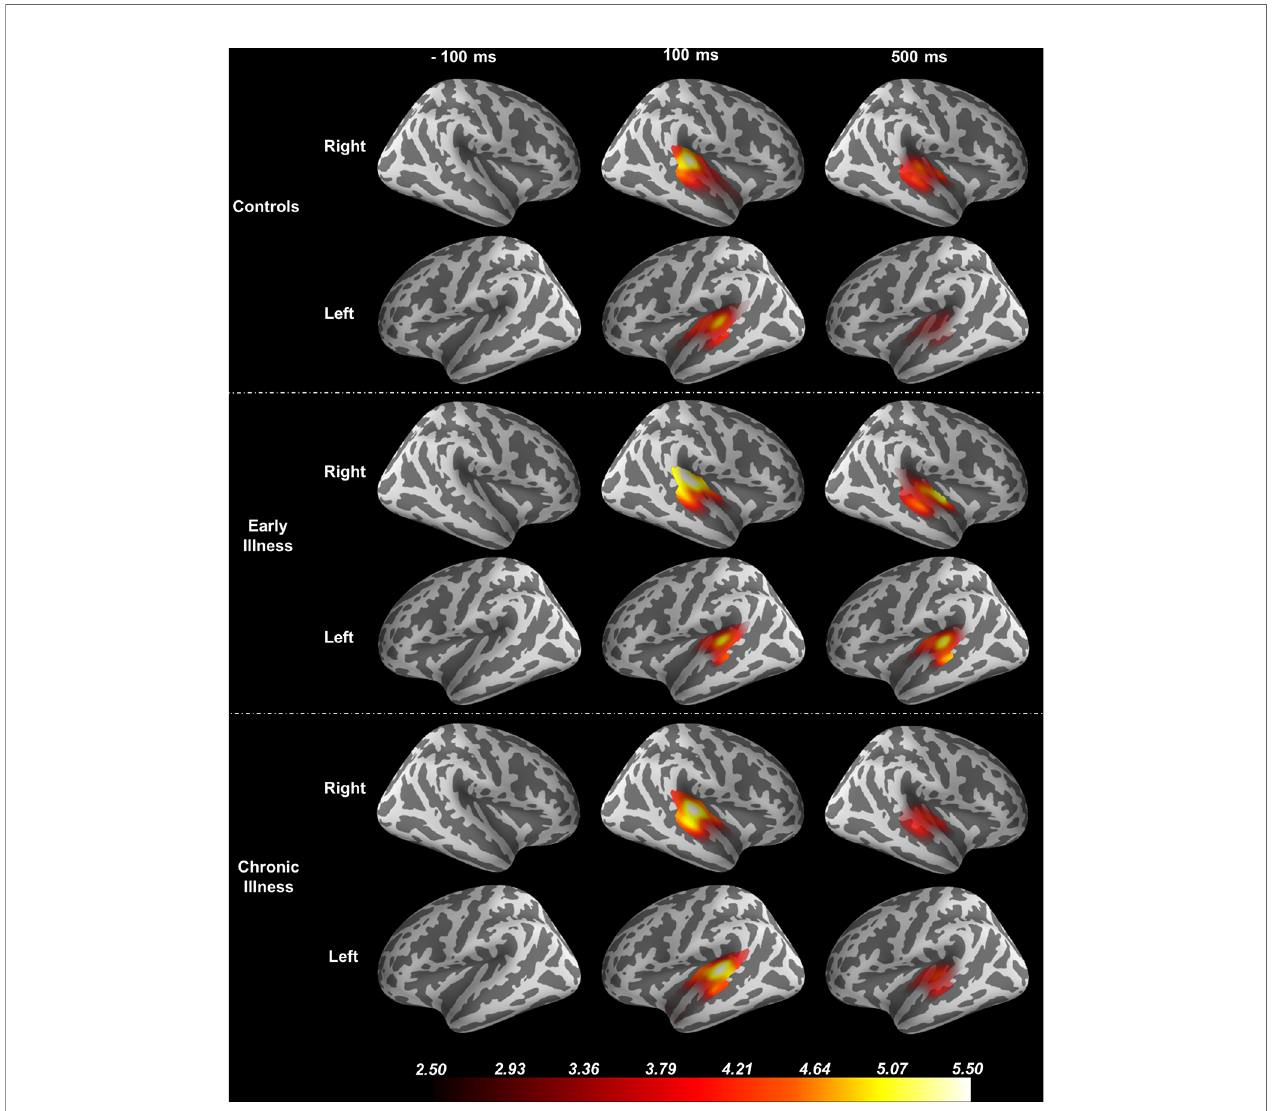
FIGURE 1 | Source Localization of the 40-Hz ASSR evoked data using dSPM. The source estimates are restricted to the anatomical label of bilateral transverse temporal cortex and superior temporal gyrus and remapped (morphed) onto the FreeSurfer average